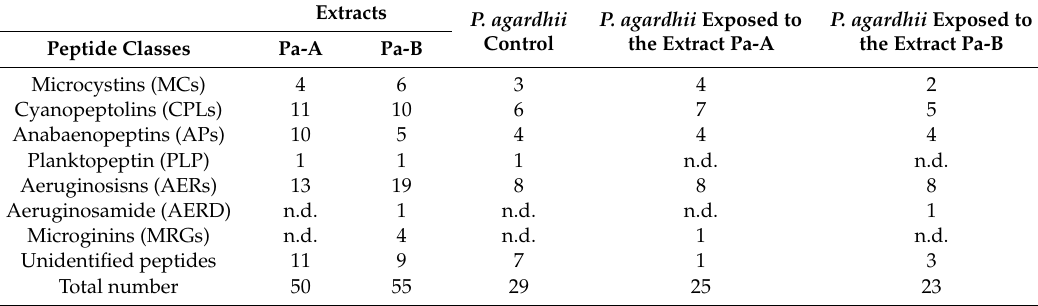
Table 2. Composition and number of oligopeptides found in two di ff erent extracts (Pa-A and Pa-B) of P. agardhii -dominated scum samples, and in the biomass of the control P. agardhii and P. agardhii exposed for seven days to the highest concentrations of the cyanobacterial extracts. Extracts P. agardhii P. agardhii Exposed to P. agardhii Exposed to Control the Extract Pa-A the Extract Pa-BPeptide Classes